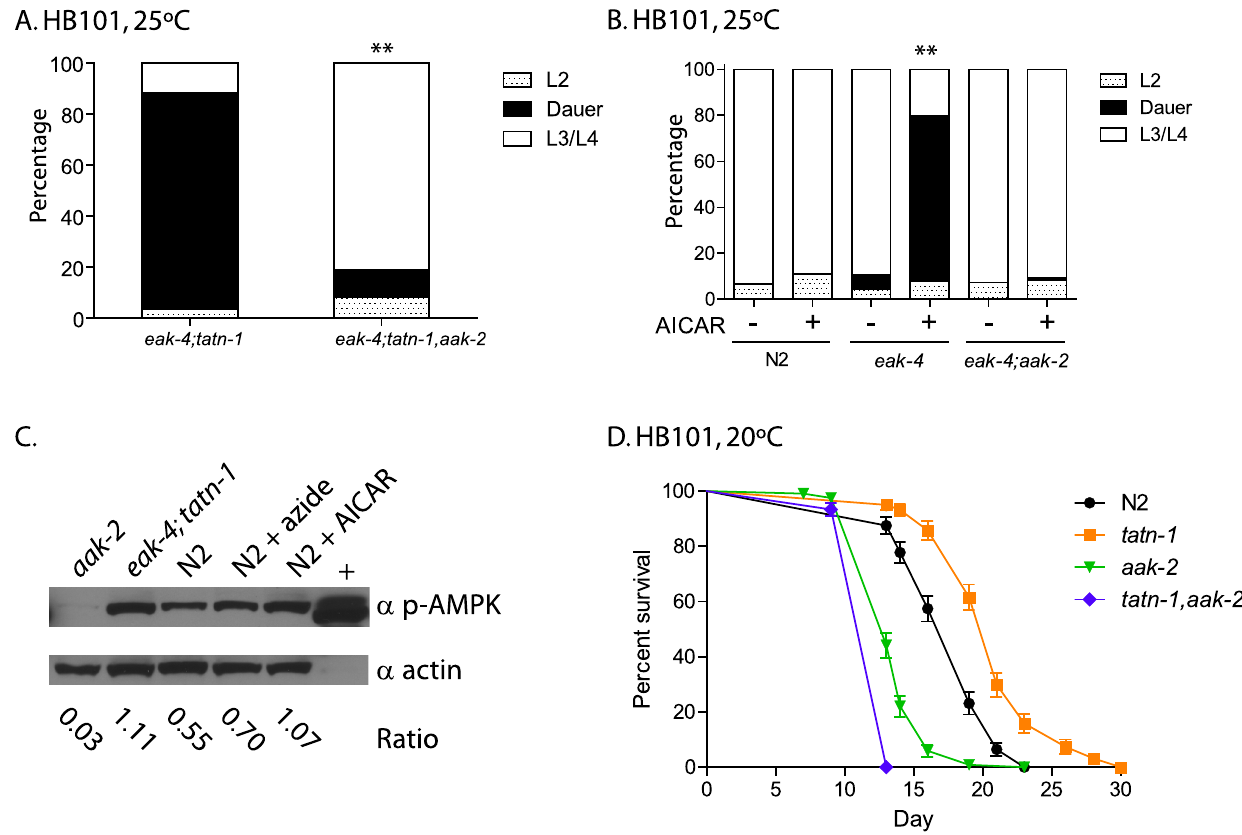
Figure 5. aak-2 activity is necessary and sufficient for tatn-1 effects on development and longevity. (A) The effects of tatn-1(baf1) on dauer formation require the aak-2 /AMPK gene. ** p , 0.001 by Fisher’s exact test. (B) Activation of aak-2 with the AMPK agonist AICAR (0.125 mM) mimics the effects of tatn-1 on eak-4(mg348) mutants. The effect of AICAR depends on aak-2 /AMPK because an eak-4 ; aak-2 mutant fails to respond to AICAR. ** p , 0.001 for comparison of eak-4 with and without AICAR by Fisher’s exact test. (C) Levels of phospho-AAK-2 are increased in eak- 4(mg348); tatn-1(baf1) L2 larval worms or N2 L2 larval worms treated with 1 mM AICAR compared to untreated N2 L2 larval worms. Levels of phospho-AAK-2 was detected using an anti-phospho-T172 specific antibody, and actin was a loading control. The ratio represents the level of phospho-AMPK normalized for the actin level in each lane. N2 larval worms treated with 10 mM sodium azide to deplete ATP levels and the AMPK positive control extract ( + ) (Cell Signaling Technologies) were included as positive controls. (D) aak-2 is required for tatn-1 effects on lifespan. Mean survival for N2, tatn-1(baf1) , aak-2(gt33) , and tatn-1(baf1); aak-2(gt33) were 18.0, 21.0, 14.0, and 13.0 days, respectively. p , 0.001 for all pairwise curve comparisons by log-rank